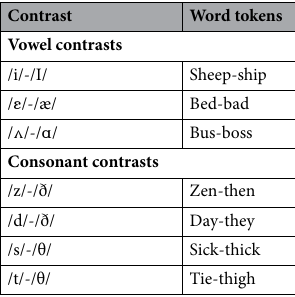
Table 1. Examples of stimuli in the categorical AXB discrimination